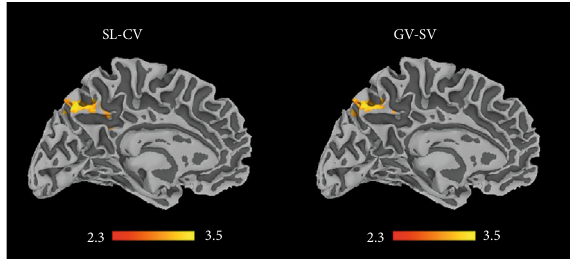
Figure 4: Neuroimaging-behavioral correlations, in particular correlations of brain activity during AO of gait and (a) SL-CV or (b) GV-CV. The results are cluster corrected for multiple comparisons ( Z ≥ 2 : 3 , p < 0 : 05 ) and are shown in MNI